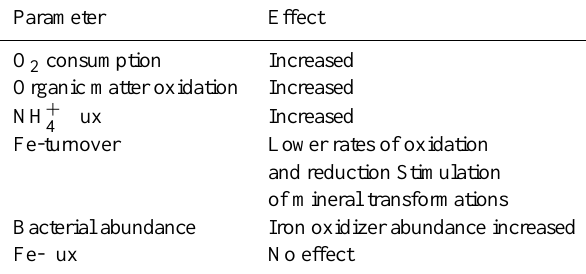
Table 2. Effects of chironomid larvae on sediment